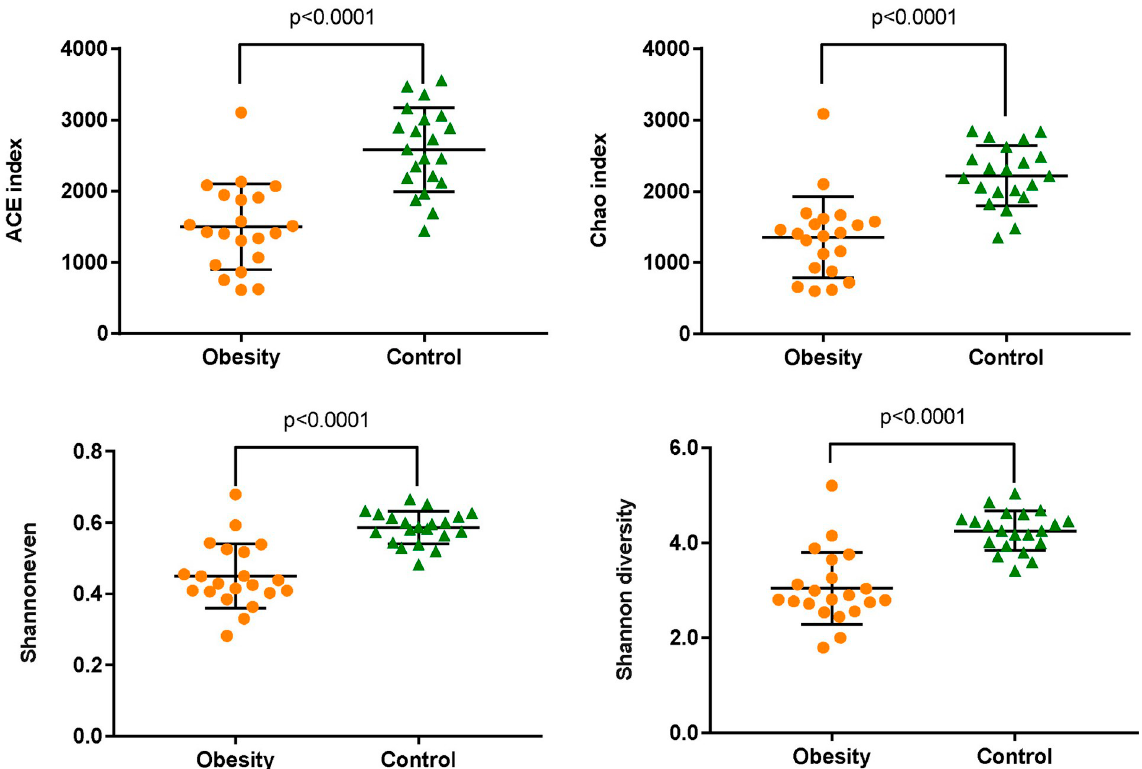
Fig 2. Comparison of bacterial richness, evenness and diversity between Obesity and Control groups.